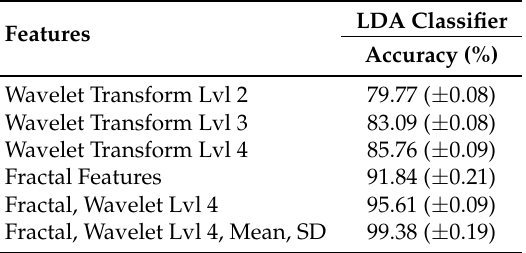
Table 3. Classification accuracy for features.